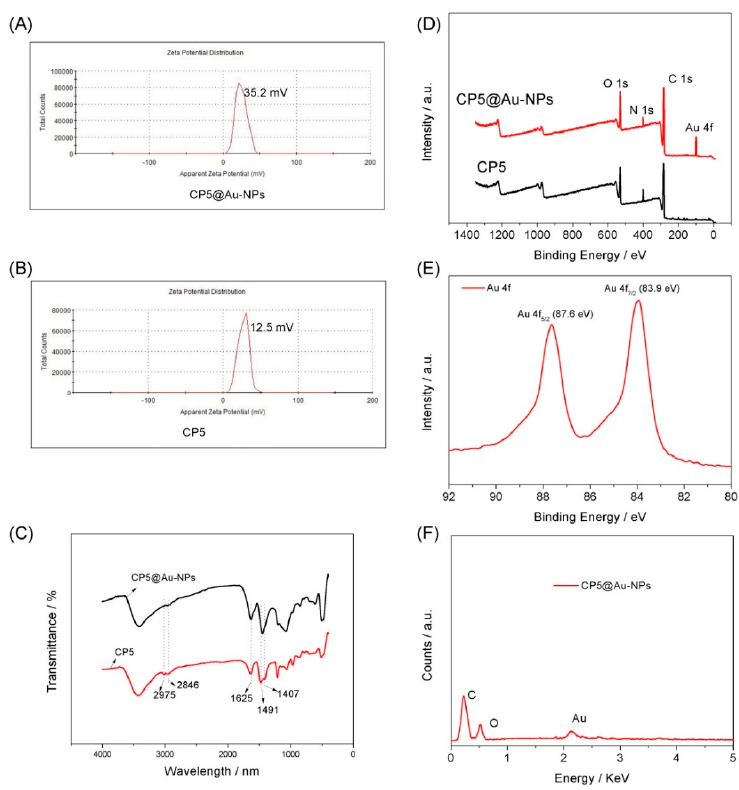
Figure 2. Zeta potential of CP5@Au-NPs ( A ); Zeta potential of CP5 ( B ); FTIR spectra of CP5@Au-NPs and CP5 ( C ); XPS survey spectrum of CP5@Au-NPs and CP5 ( D ); high resolution XPS spectra of Au 4f ( E ); EDS spectra of CP5@Au-NPs ( F ).